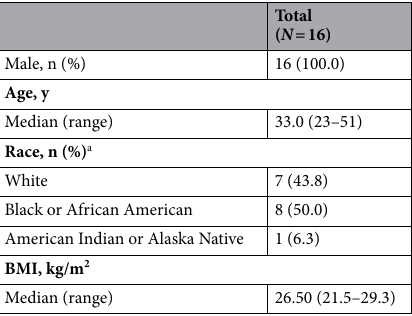
Table 1. Baseline characteristics. BMI, body mass index. a Percentages may not sum to 100.0% due to rounding.